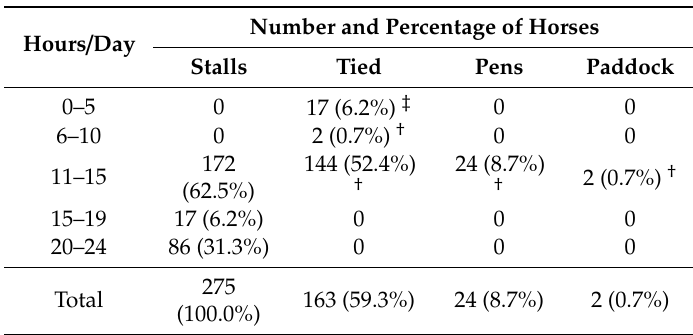
Table 2. Routine management of Chilean corralero